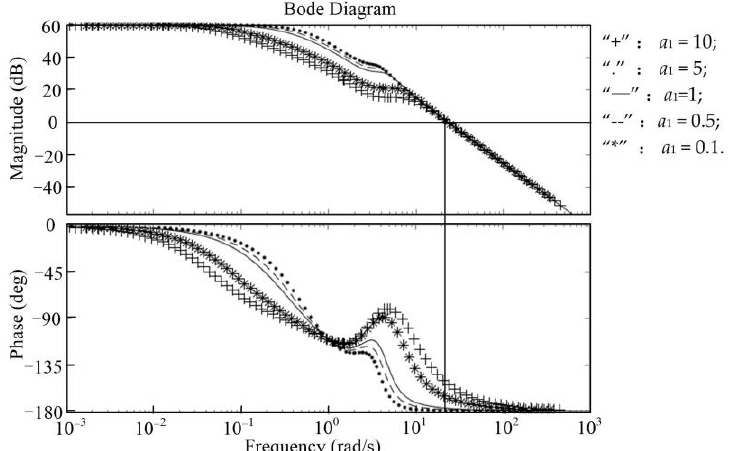
Figure 8. Bode diagram of the external disturbance to the system output transfer function when a 1 changes.